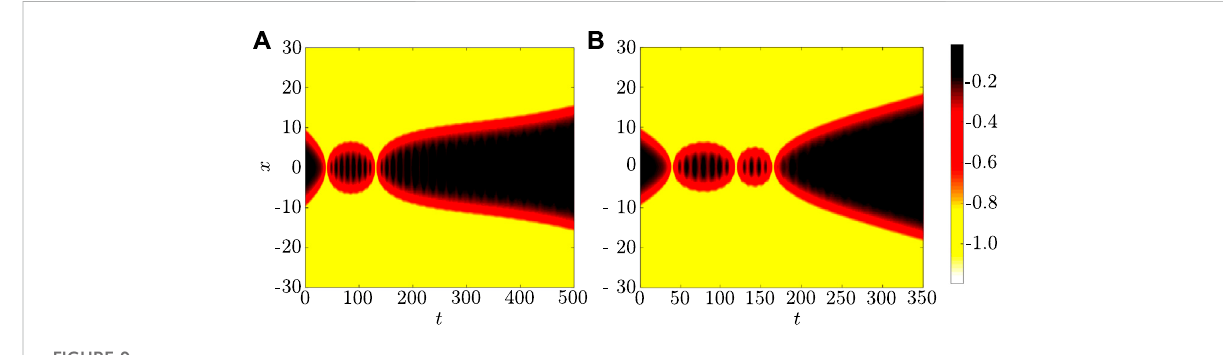
FIGURE 9 Space-time contour plot of the scalar fi eld of the kink – antikink interaction in the ϕ 8 model showing (A) two-bounce and (B) three-bounce windows. Adapted from [28].